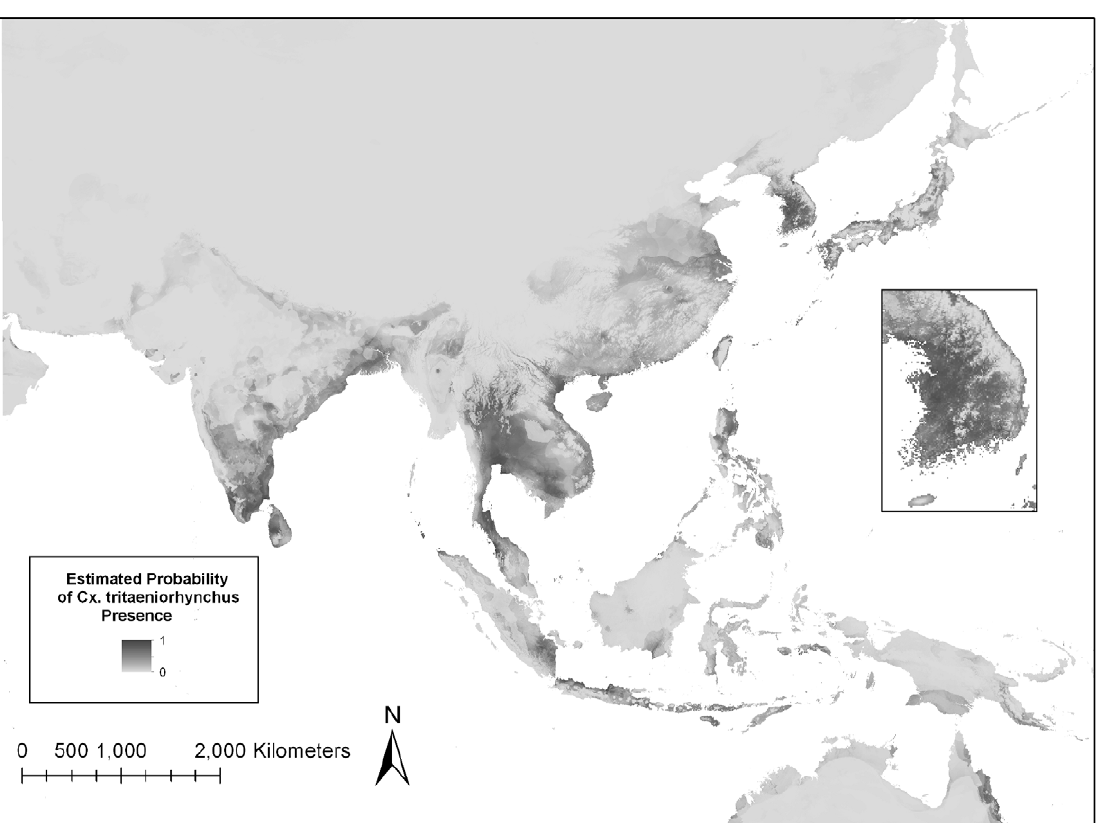
Figure 3. Maxent model estimation of the probability of Cx.tritaeniorhynchus distribution in the JE endemic region. Darker areas indicate areas that are likely to have suitable habitat for this vector species while lighter areas indicate areas of that are less suitable for the vector.